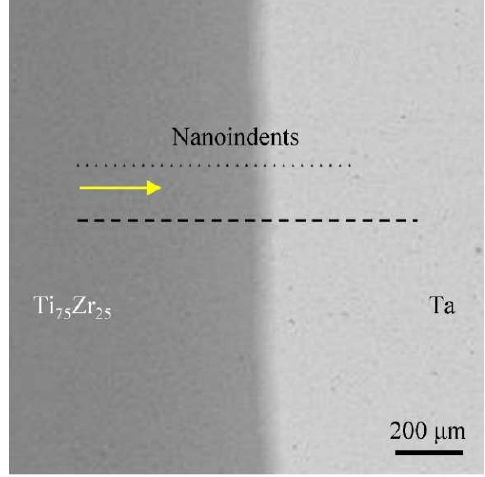
Figure 2. Optical microscopy image of annealed diffusion couple. Triangles are the nanoindents, the arrow is the test direction, the dashed line indicates the EPMA test